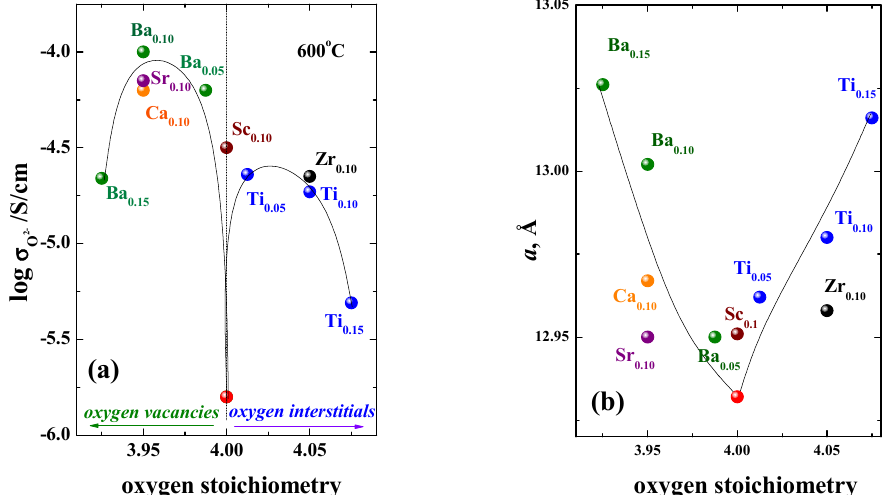
Figure 15. The values of oxygen-ionic conductivity ( a ) and lattice parameter a ( b ) vs. oxygen stoichiometry in doped compositions based on BaLaInO 4 : BaLaIn 0.9 Sc 0.1 O 4 (Sc 0.1 ) [83], BaLaInO 4 (red symbol) [74], Ba 1.05 La 0.95 InO 3.975 (Ba 0.05 ) [79], Ba 1.1 La 0.9 InO 3.95 (Ba 0.1 ) [79], Ba 1.15 La 0.85 InO 3.925 (Ba 0.15 ) [79], BaLa 0.9 Ca 0.1 InO 3.95 (Ca 0.1 ) [74], BaLa 0.9 Sr 0.1 InO 3.95 (Sr 0.1 ) [74], BaLaIn 0.95 Ti 0.05 O 4.025 (Ti 0.05 ) [80], BaLaIn 0.9 Ti 0.1 O 4.05 (Ti 0.1 ) [80], BaLaIn 0.85 Ti 0.15 O 4.075 (Ti 0.15 ) [80], BaLaIn 0.9 Zr 0.1 O 4.05 (Zr 0.1 ) [78]